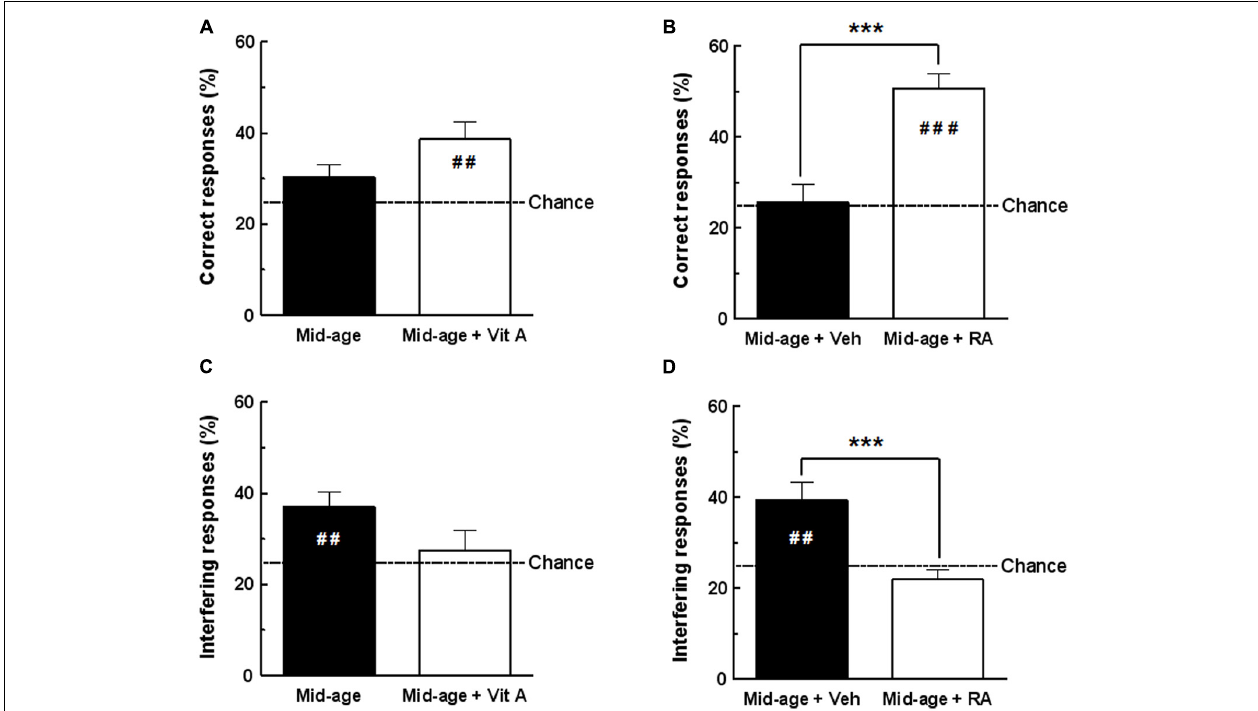
FIGURE 3 | Effects of vitamin A supplementation and RA treatment on D1 retrieval. (A) The percentage of correct responses for vitamin A supplemented group was different from the chance level (25%) compared to control group. (B) The percentage of correct responses for RA-treated group was increased compared to vehicle and different from chance level. (C) The percentage of interfering responses for vitamin A supplemented